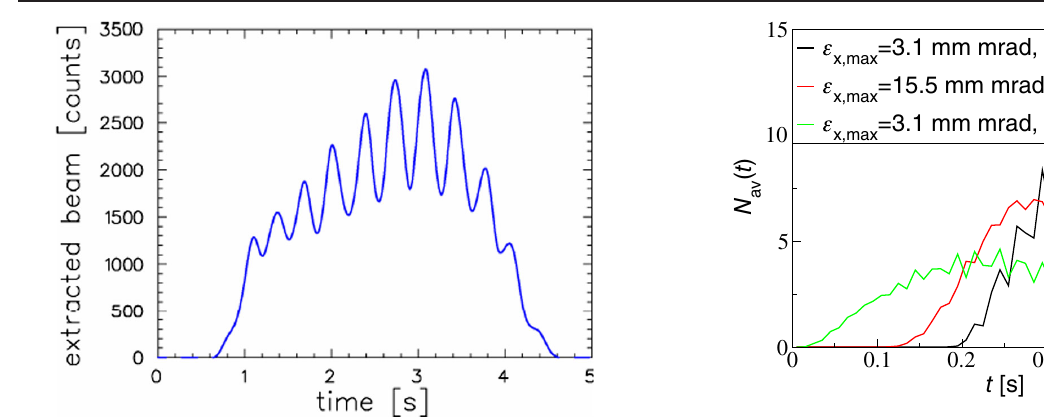
FIG. 4. Spill of an Ar 18 þ beam measured during slow extraction from SIS18 at the beam energy E ¼ 500 MeV = u bunched with ¼ 12 kV and harmonic number the rf voltage of amplitude V rf h ¼ 5 .